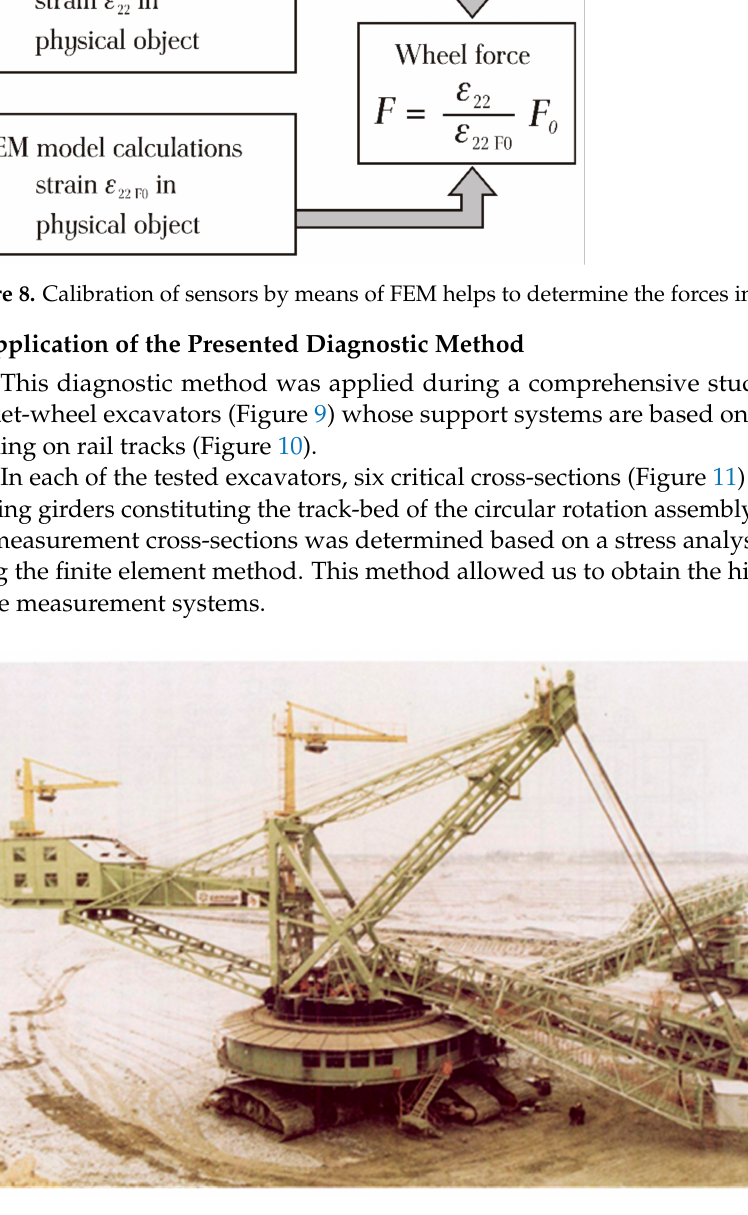
Figure 9. One of the tested bucket-wheel